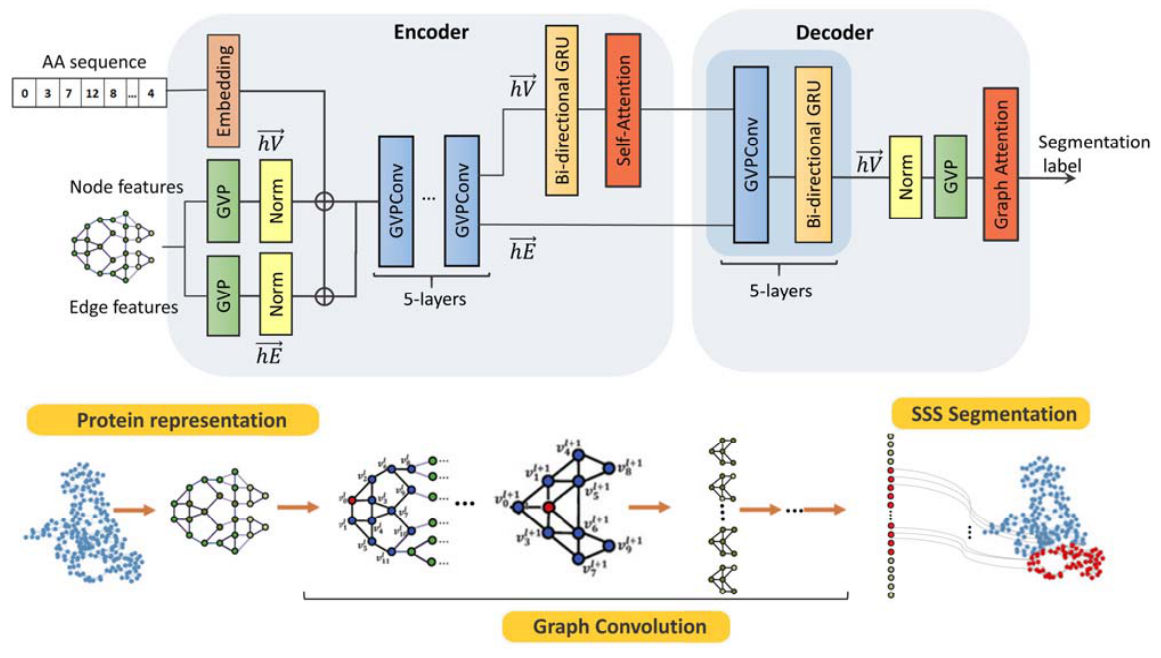
Figure 3. The architecture of the proposed PSSNet.